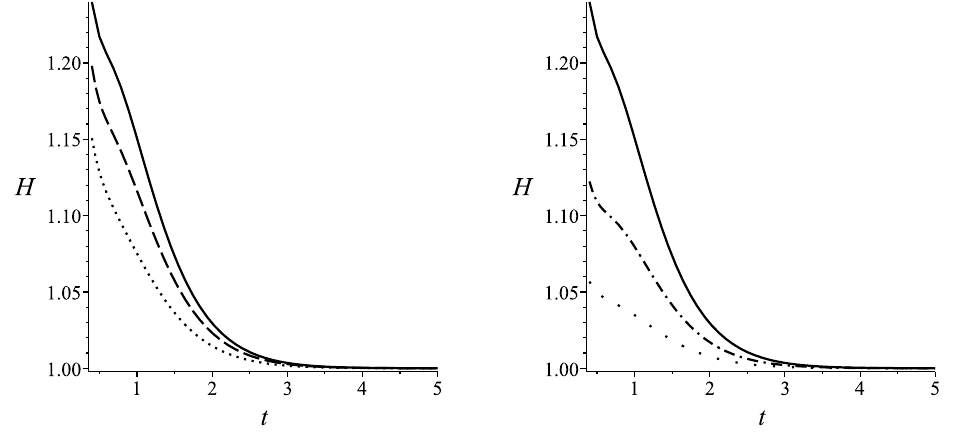
Figure 3 . The trajectories same values of the constants as in (cid:12)gure 1.